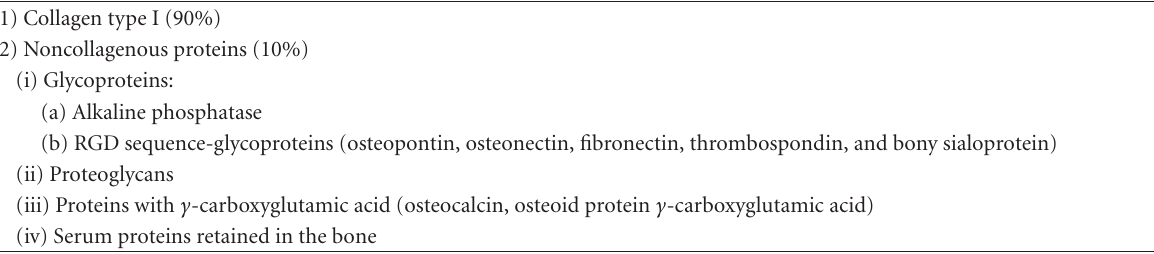
Table 1: Osteoid matrix